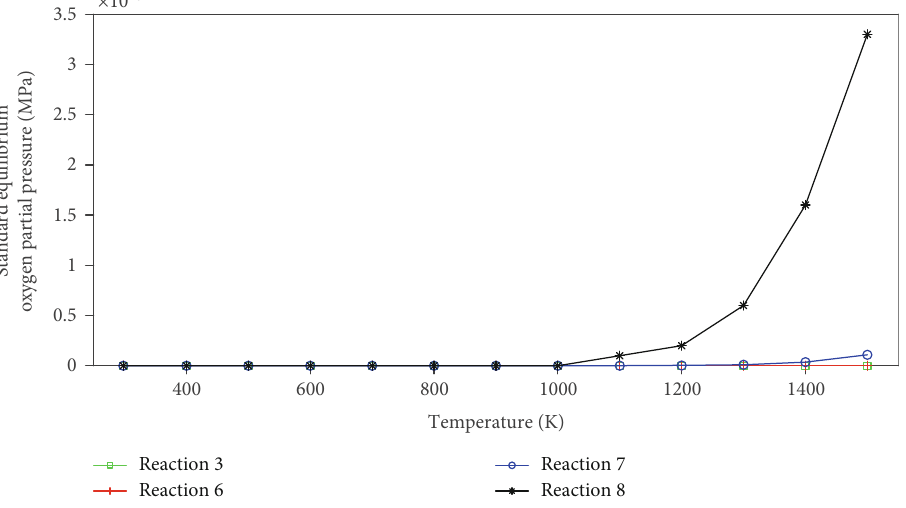
Figure 5: Standard equilibrium oxygen partial pressure at di ff erent